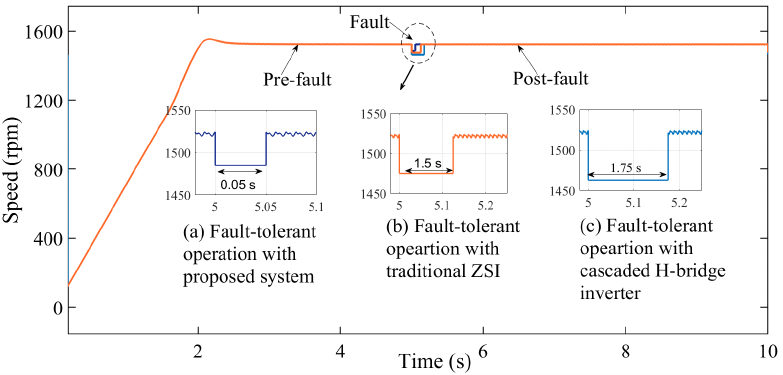
Figure 19. Recovery time characteristics of fault-tolerant